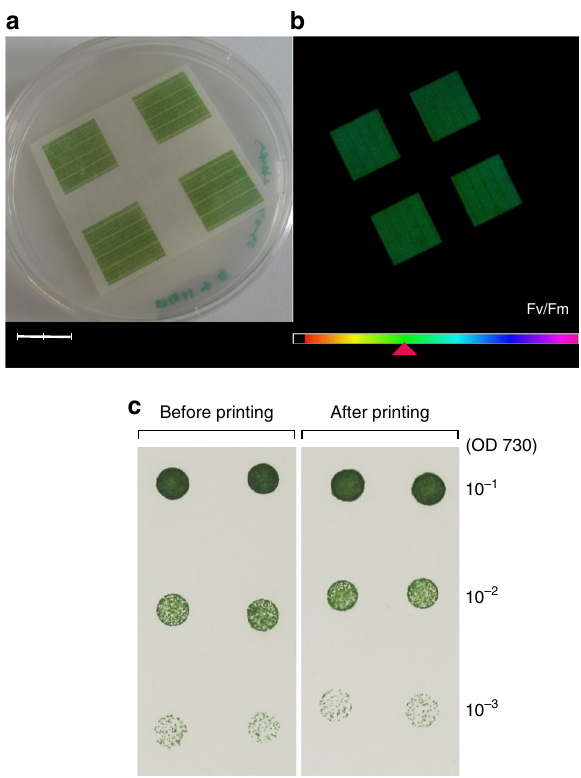
Fig. 1 Cell viability and photosynthetic capabilities of digitally printed cyanobacteria. a Photograph of inkjet-printed Synechocystis cells after 3 days of incubation. Scale bar measures 2 cm. b Chlorophyll fl uorescence image of the sample a by imaging PAM, showing maximum quantum ef fi ciency of PSII (Fv/Fm) at the values of about 0.4 according to colour gradient in the legend bar. c The panel compares the growth of Synechocystis colonies before and after the inkjet printing process, following 5 days of incubation on a BG-11 agar plate. A 3 µ l aliquot of cells from a dilution series representing 10 − 1 , 10 − 2 and 10 − 3 of the original suspension was spotted. For the most dilute cell suspension taken after printing, 90.5 ± 10.6 colonies were counted, whereas 87.5 ± 12.0 colonies were counted before printing. The difference between these values was found to be not statistically signi fi cant (one-way ANOVA: p = 0.815) (Supplementary Table